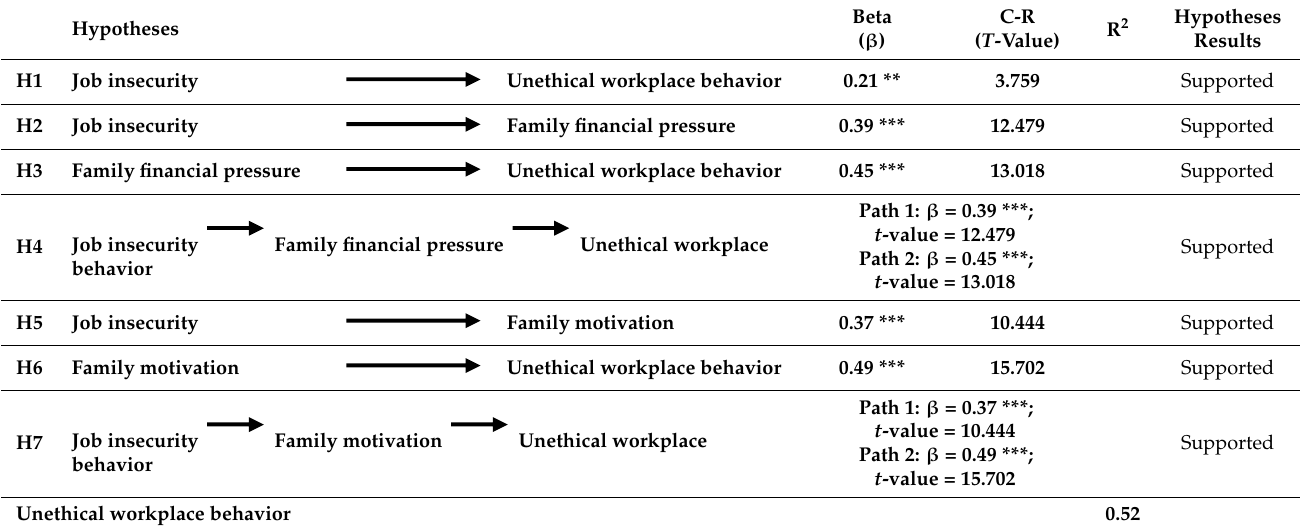
Table 3. Result of structural model.